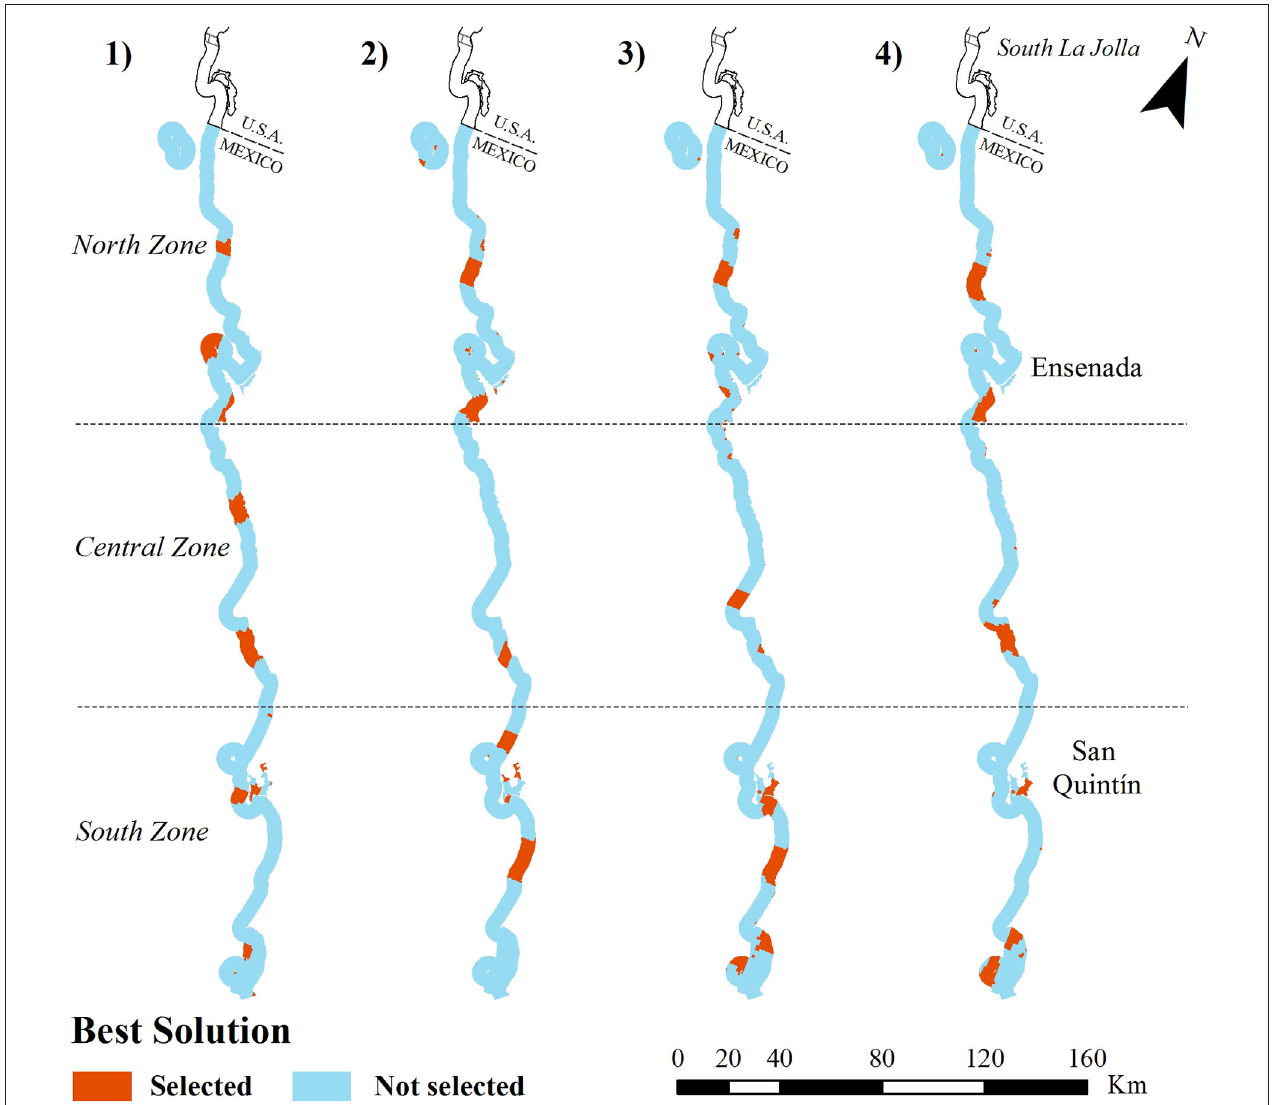
FIGURE 4 | Best solution (network of MPAs selected in the best solution of 100 runs with Marxan) of the four scenarios: (1) Representation, (2) Cost, (3) Condition, (4)